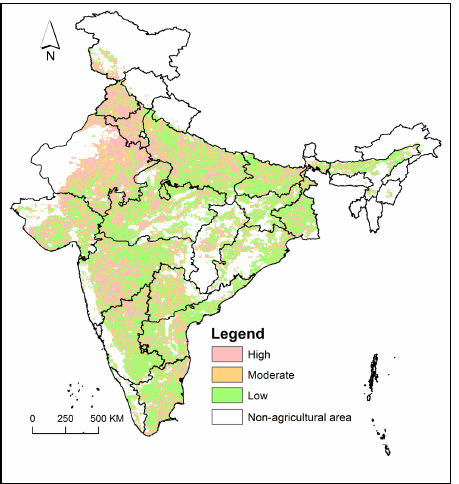
Figure 17 Vulnerability Map of Meteorological Drought During 2003- 2015.